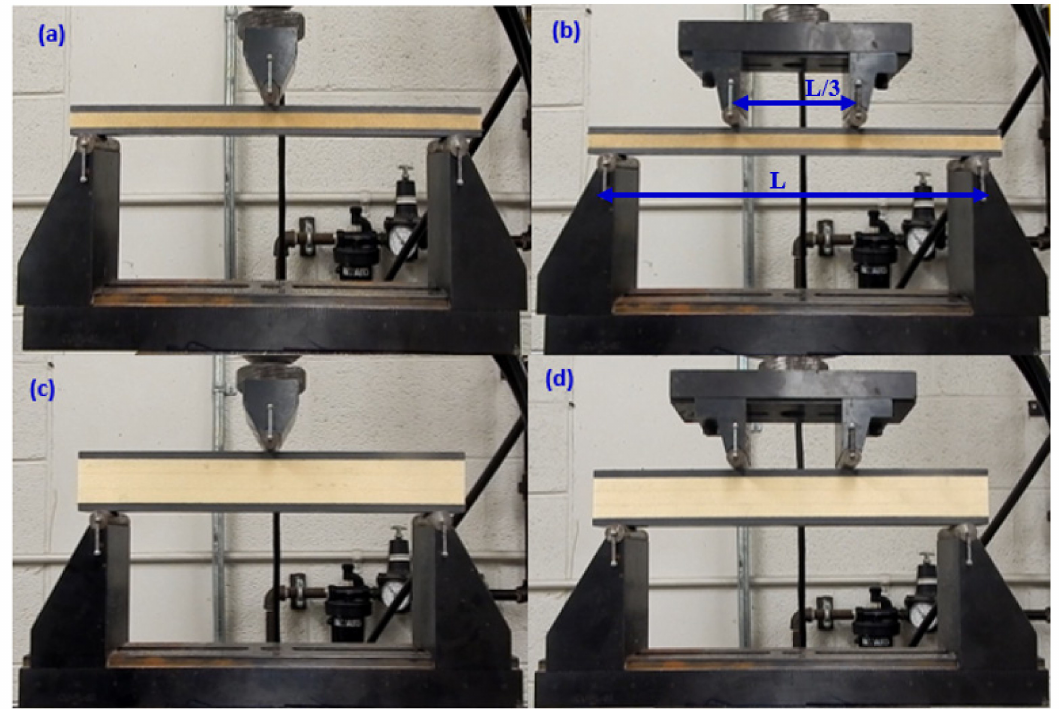
Figure 2. Three-point and four-point flexural test setup pertaining to specimens that had ( a , b ) a core thickness of 9 mm; ( c , d ) a core thickness of 29